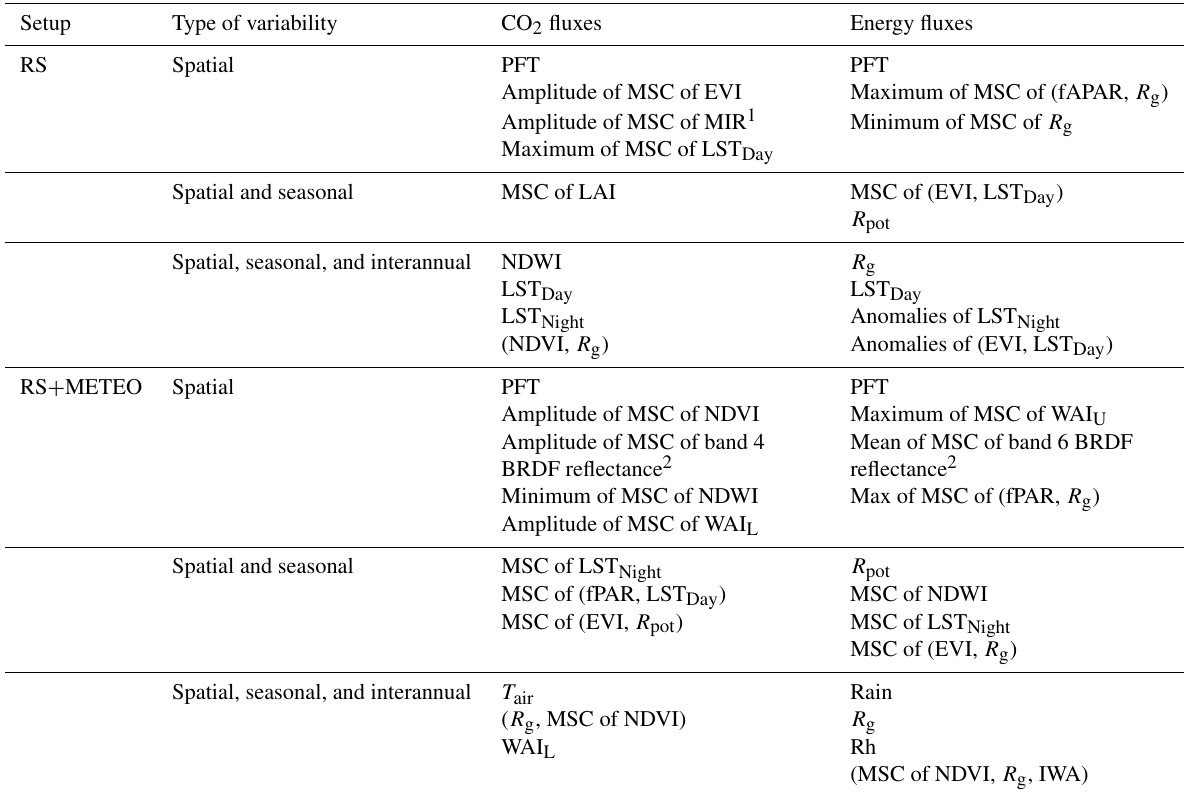
Table C1. This table has been reproduced from Table 2 of Tramontana et al. (2016) and the original caption is the following one.